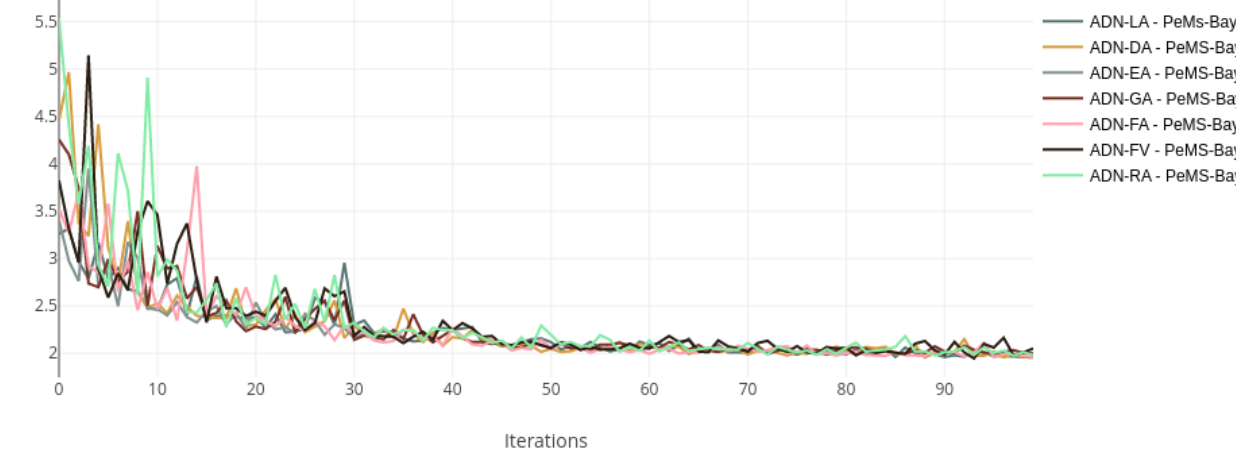
Figure 5. Validation loss curves—ADN on